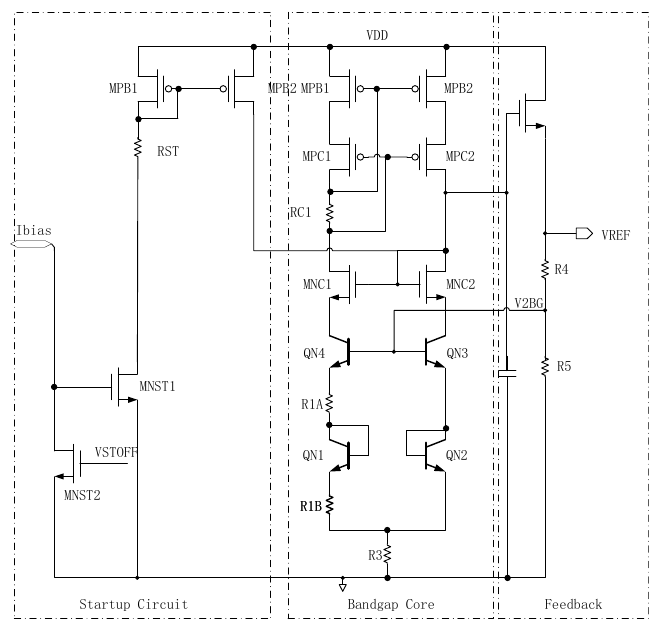
Figure 5. Detailed stacked bandgap reference (SBGR) core circuit.